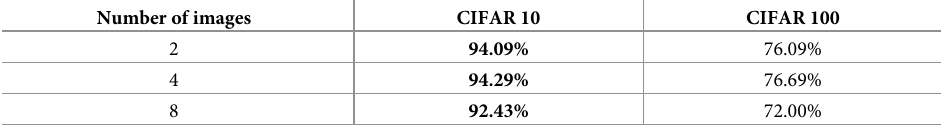
Table 5. CIFAR dataset classification experiment results according to the number of images used for data augmentation.